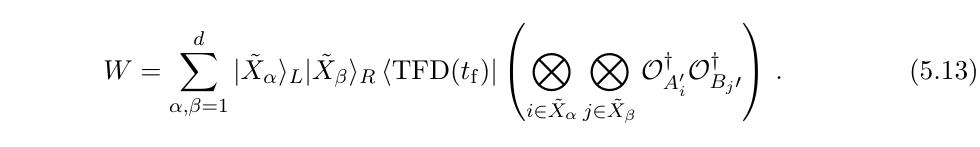
1 reaches the boundary for this particular choice of boundary j